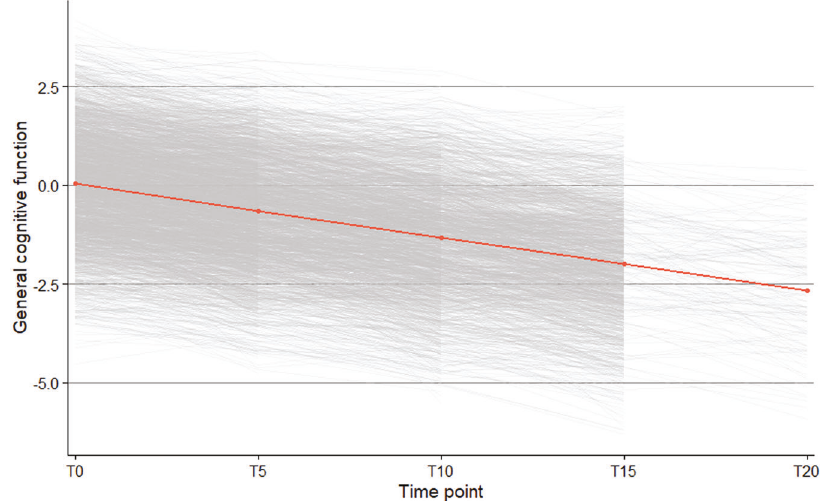
Fig. 2 Trajectories of general cognitive function. This fi gure shows the trajectories (with 95% con fi dence intervals) of general cognitive function up to 20-years follow-up ( n = 2559). The general cognitive function measure is based on sex, age and examination round-adjusted standardized residuals. T0-T20 represents time in years. The red dots represent mean general cognitive function at each time